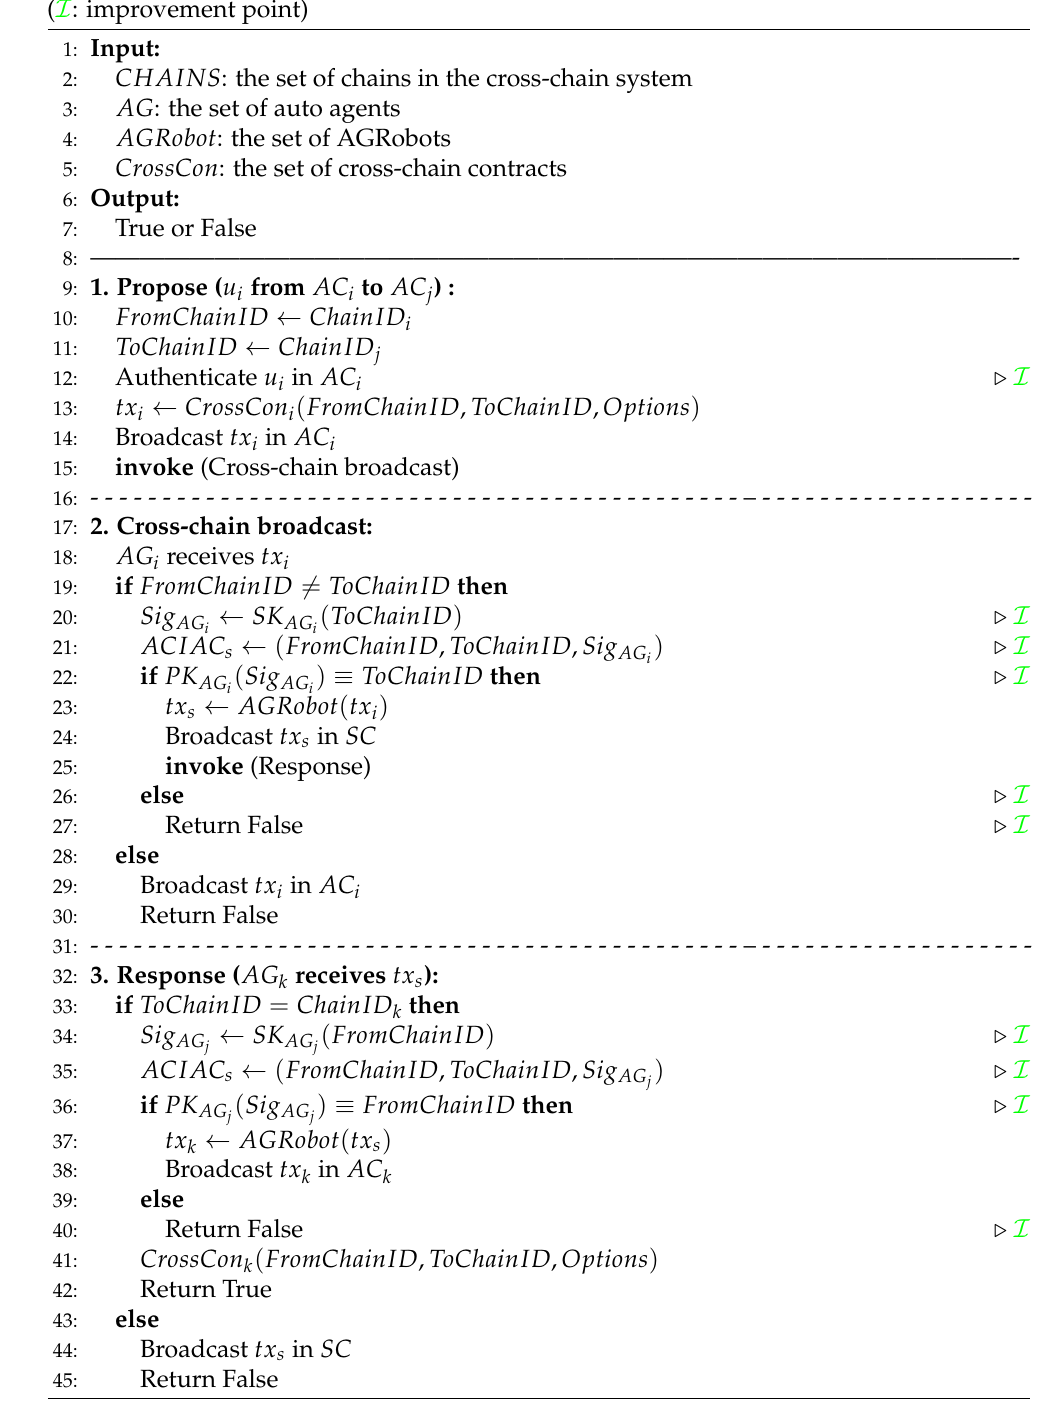
Algorithm 2 Cross-chain data circulation with access control and identity